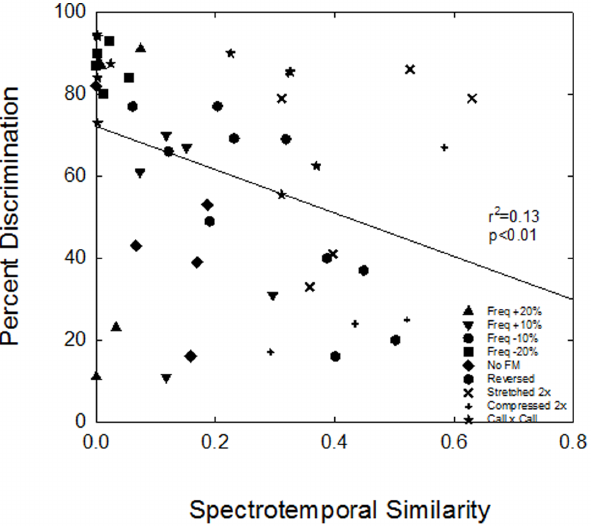
Figure 4. Discrimination of manipulated vocalizations. Mean discrimination performance across subjects and across the five background vocalization types for the eight vocalization manipulations. Error bars are between-subjects standard errors. The blue horizontal dashed lines represent chance level performance.